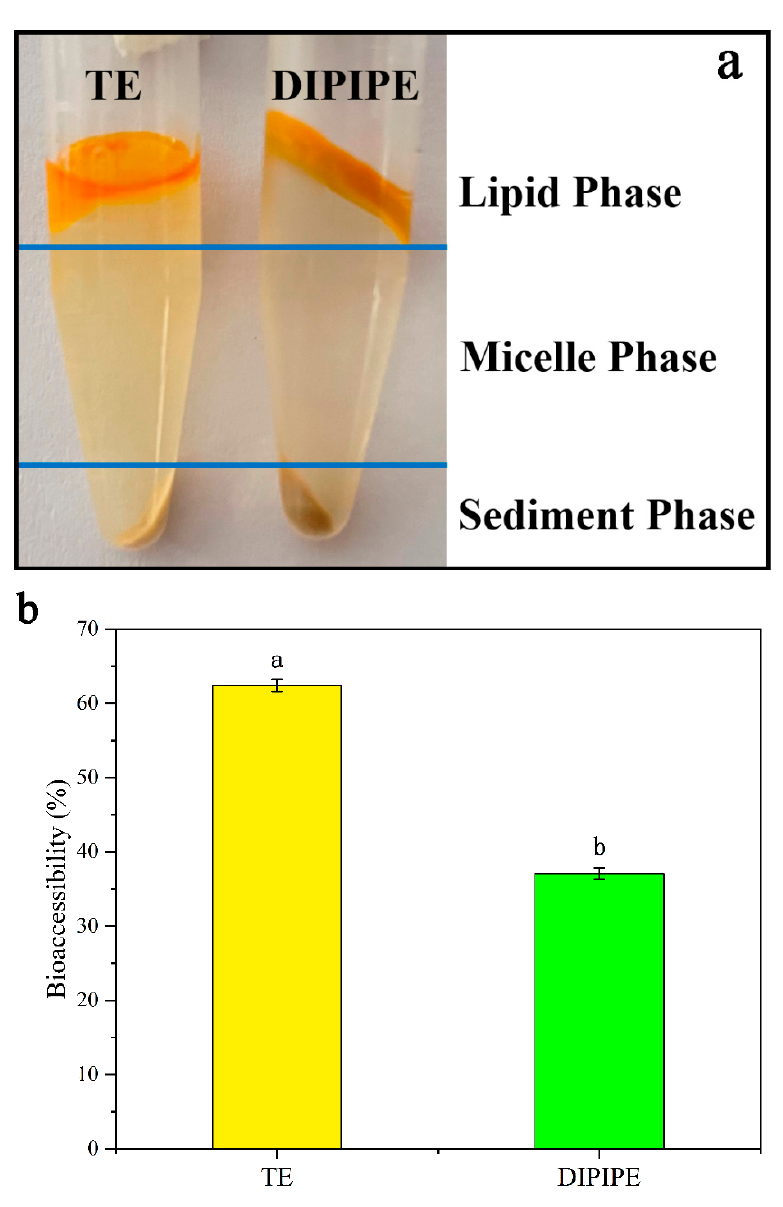
Figure 3. ( a ) Appearance of the micellar layer. ( b ) Bioaccessibility of β -carotene (TE and DIPIPE data results are marked with different lowercase letters indicating that the difference is significant at the 0.05